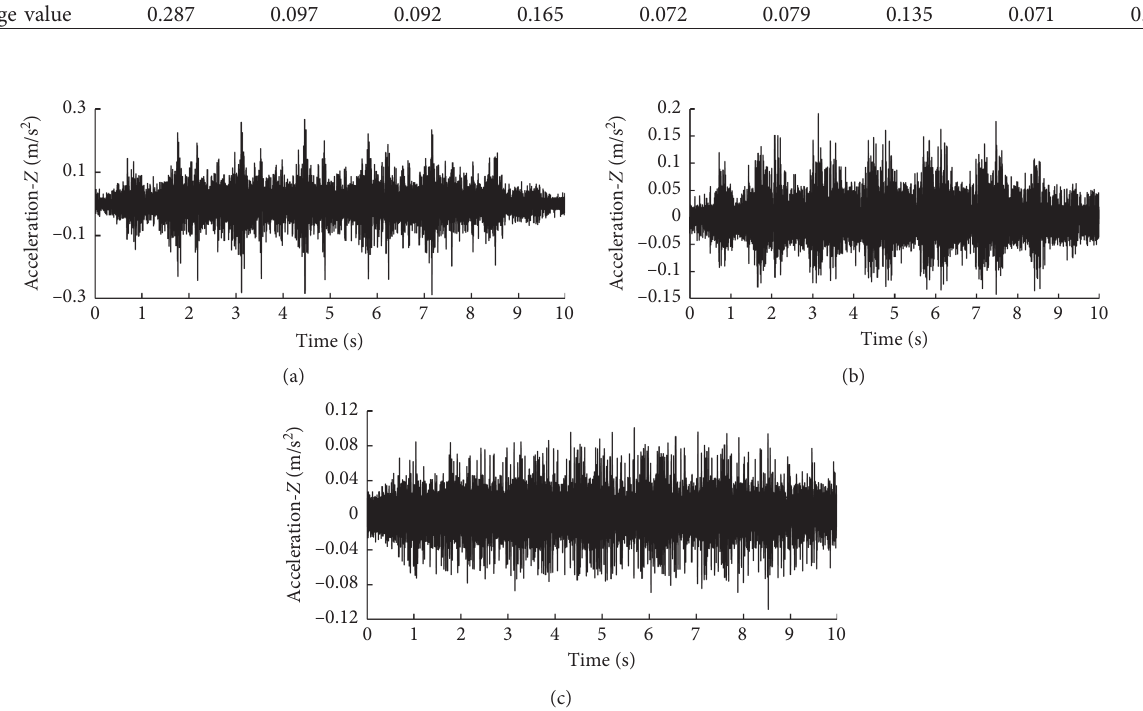
Figure 10: Time history curves of vertical accelerations: (a) 1#; (b) 2#; (c)